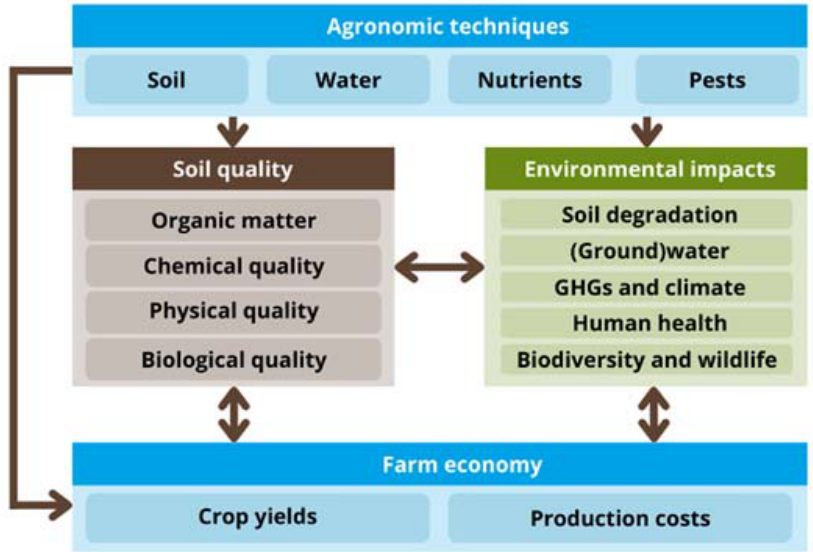
Figure 2. Impacts of agronomic techniques for managing soil, water, nutrients, and pests. One-sided arrows indicate impact, while two-sided arrows indicate that factors influence each other. Note that agronomic techniques are part of cropping systems and correspond to FML3 in Figure 1.